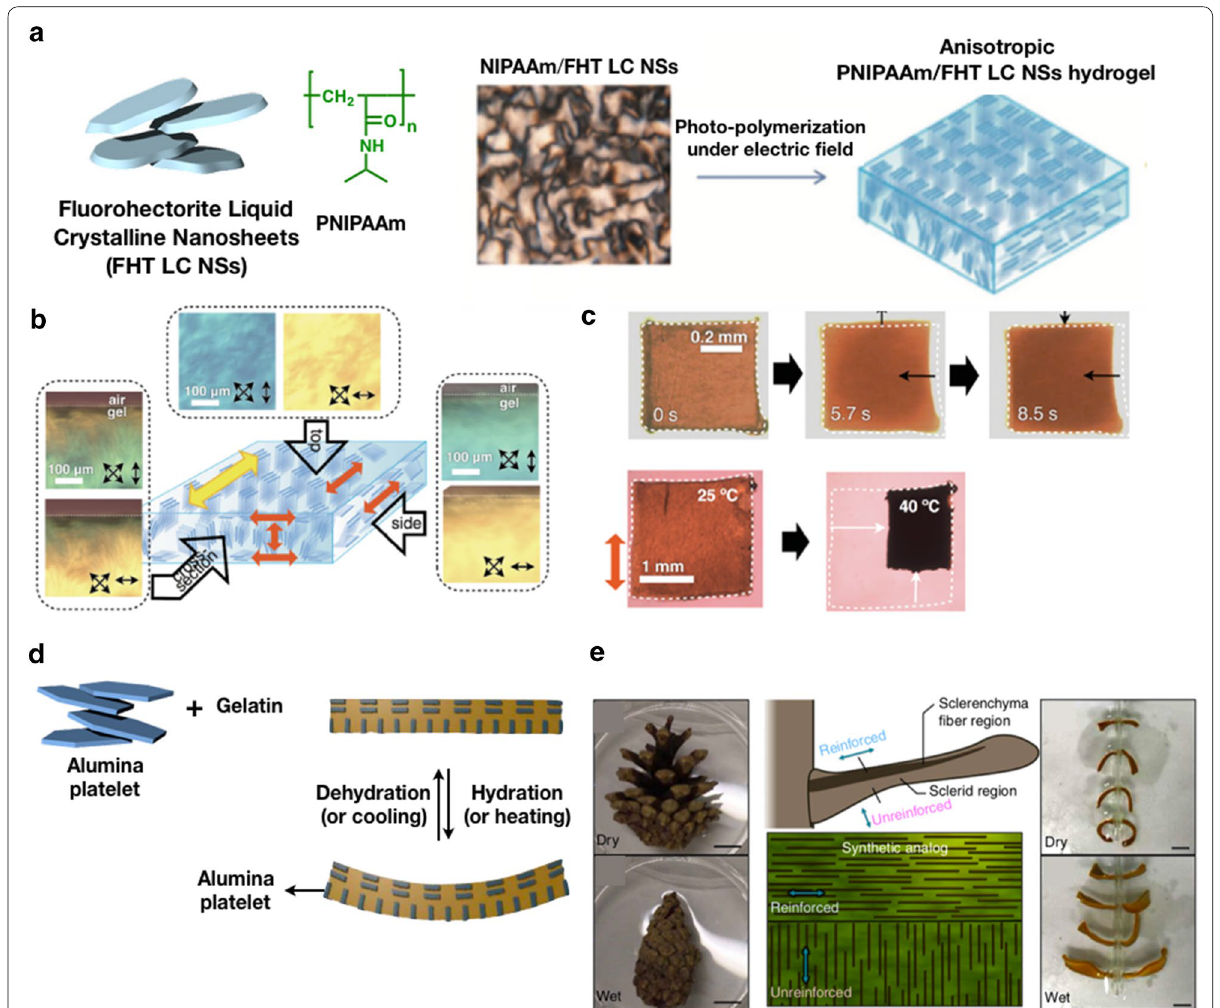
Fig. 10 a Schematic images of preparation of the anisotropy hydrogel with FHT LC NSs and PNIPAAm under electric field. b Microscopic view of the PNIPAAm/FHT LC NSs hydrogel synthesized with in-plane and out-of-plane electric field. The optically polarized images are observed with crossed polarizers and a wave plate. c Photographs of the anisotropic deformation of the PNIPAAm/FHT LC NSs hydrogel film upon photo-irradiation (top) and heating (bottom). ( a – c were reproduced with permission from Ref. [63], © 2014, Wiley–VCH Verlag GmbH & Co. KGaA, Weinheim). d Schematic of the hydrogel actuator comprising structurally oriented alumina platelets and gelatin. e Schematic images of the behavior of pinecone in dehydration/hydration process and the predominant orientation of CMFs within a pinecone scale (left). Synthetic pinecone scales constructed by oriented platelets in a bilayer structure within gelatin (right). ( d was reproduced with permission from Ref. [65], © 2013 Macmillan Publishers